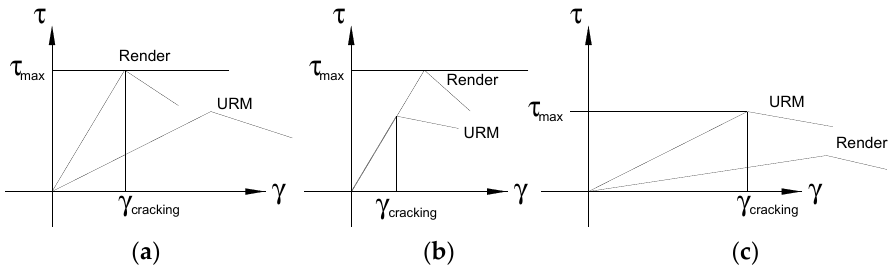
Figure 11. Effect of non-perfect plastic behavior: ( a ) typical case for high-strength (cement-based) render; ( b ) typical case of a lime-based render; ( c ) typical case of low-strength (i.e., soft thermal-insulating coating).